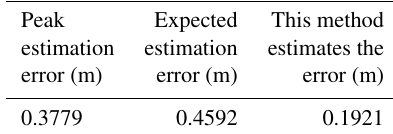
Table 4. Overall estimation error. Peak